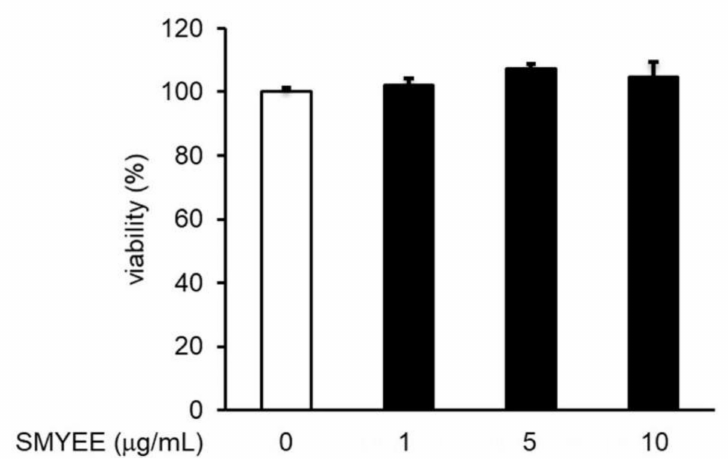
Figure 2. E ff ects of Sargassum miyabei Yendo ethanolic extract (SMYEE) on HaCaT cell viability. Cells were treated with various concentrations (1–10 µ g / mL) of SMYEE for 24 h. Cell viability was assessed using the Cell Counting Kit-8 (CCK-8) assay. The results are expressed as the percentages of surviving cells relative to those of untreated cells. The data are means ± standard error of the mean (SEM) and are representative of the results obtained in three independent